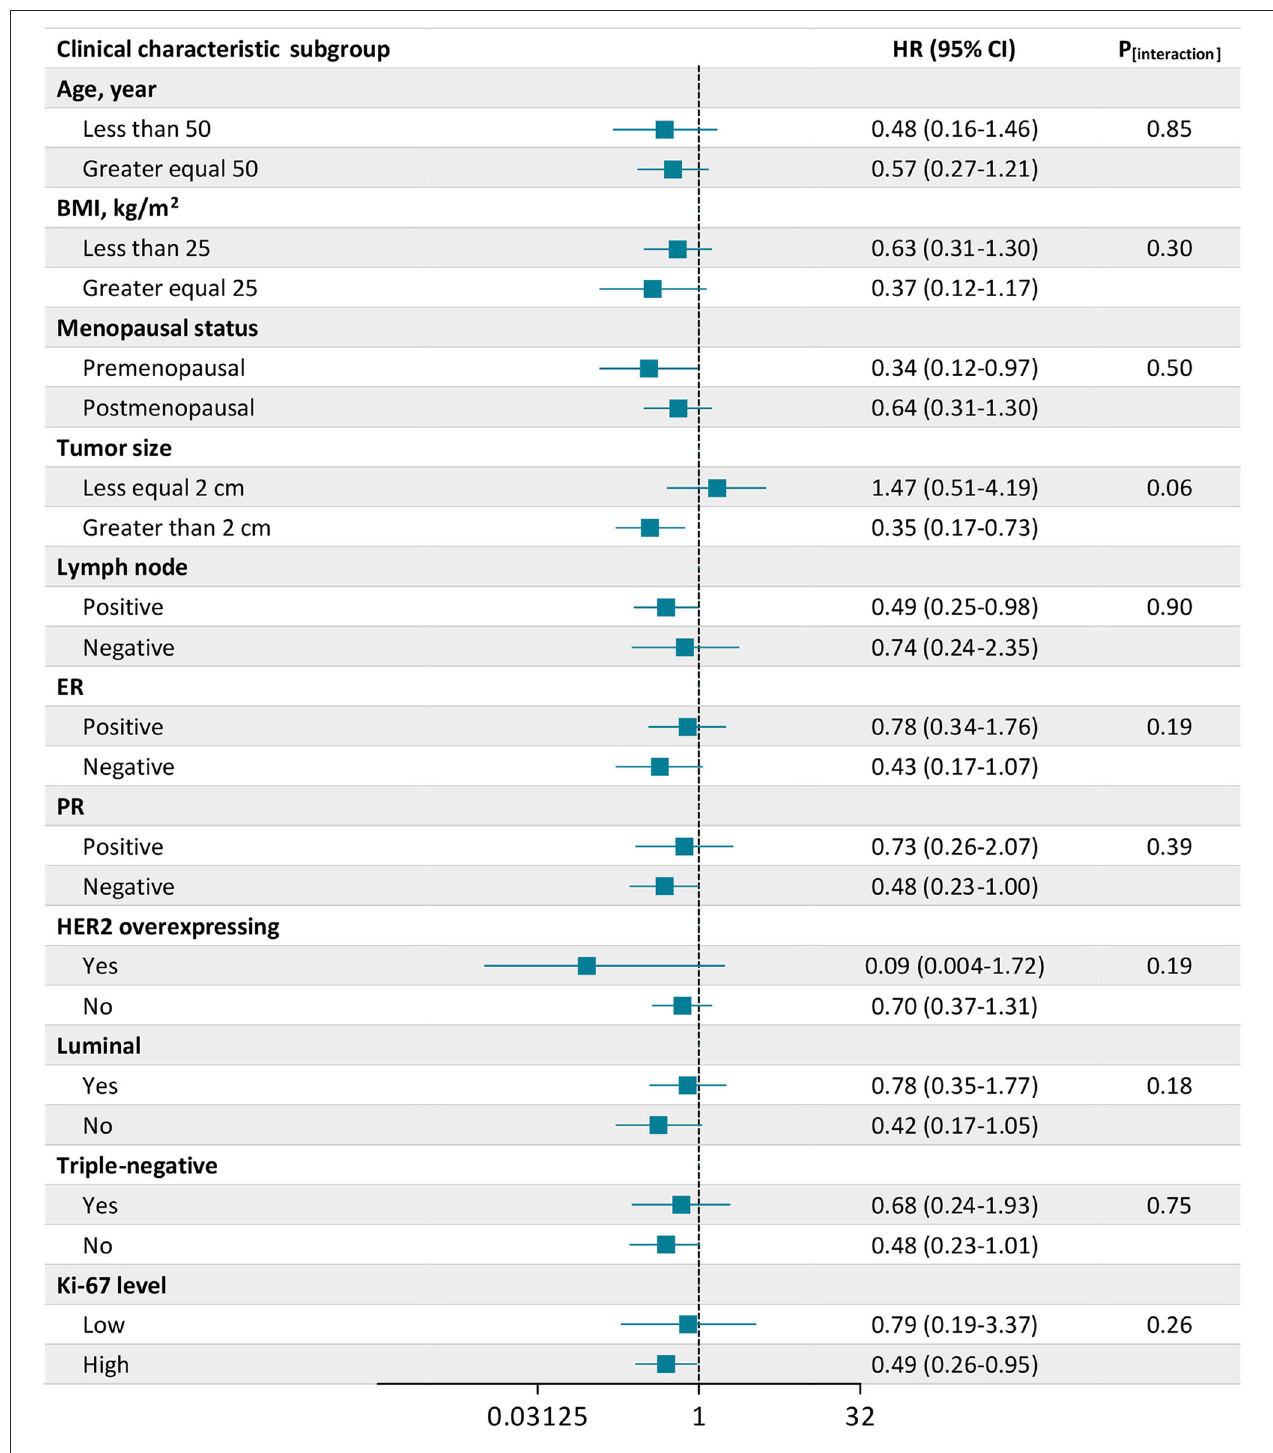
FIGURE 2 | Association of insulin-like growth factor 1 (IGF1) with all-cause mortality according to subgroups of clinical characteristics. There were 2,682 patients included in the analysis. The number of missing values was 2 for Ki-67. Plots (bars) are hazard ratios (HRs) (95% CIs) for all-cause mortality associated with a high level of IGF1 compared with a low level of IGF1. Data were adjusted for age, body mass index (BMI), menopausal status (yes or no), tumor size ( ≤ 2cm or > 2cm), lymph node status (positive or negative), chemotherapy (yes or no), radiotherapy (yes or no), endocrine therapy (yes or no), and targeted therapy (yes or no).